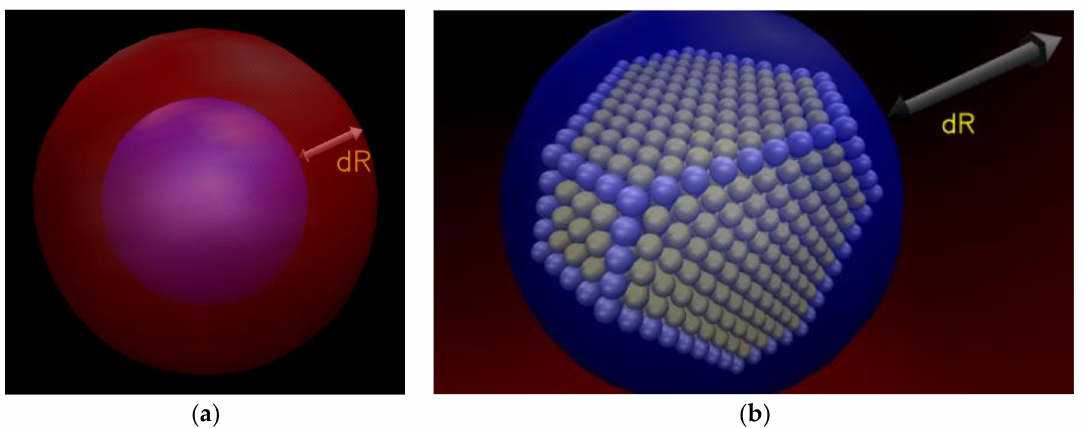
Figure 2. ( a ) A sketch of the analysis scheme in spherical shells. ( b ) Inside view of the Figure